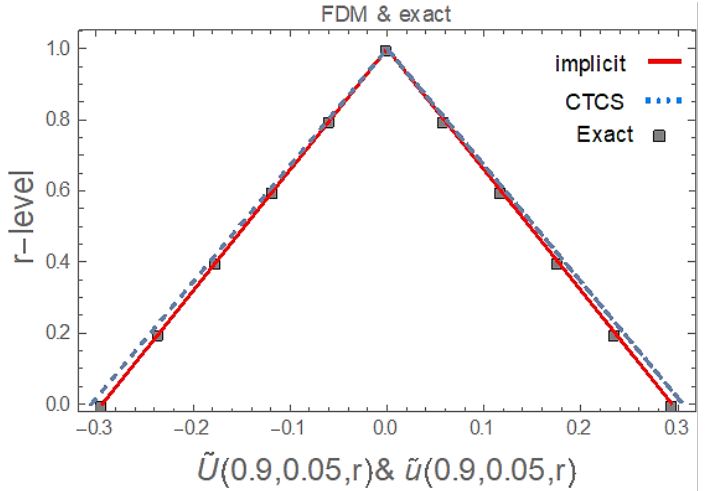
Figure 3. The exact and numerical solution of Equation (31) by CTCS and implicit schemes at 𝑡 = 0.05 and 𝑥 = 0.9 for all 𝑟, 𝛽 ∈ [0,1] .